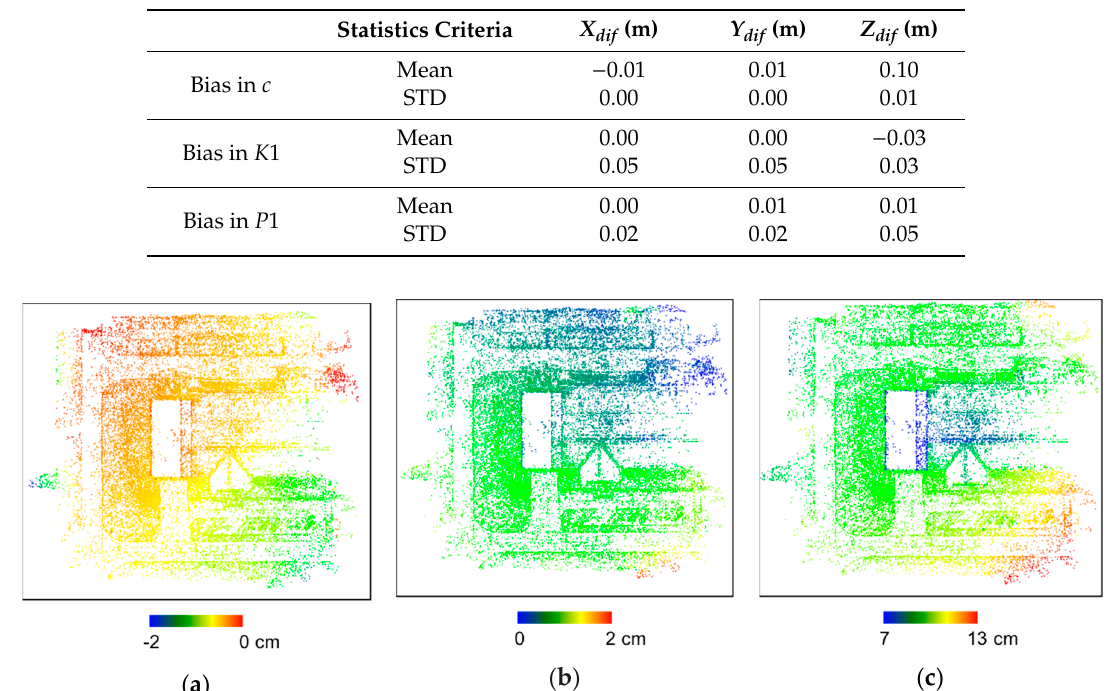
Table 3. Mean and standard deviation (STD) of the di ff erences in object point coordinates caused by a bias introduced to the reference camera IOPs for the A-1 dataset.